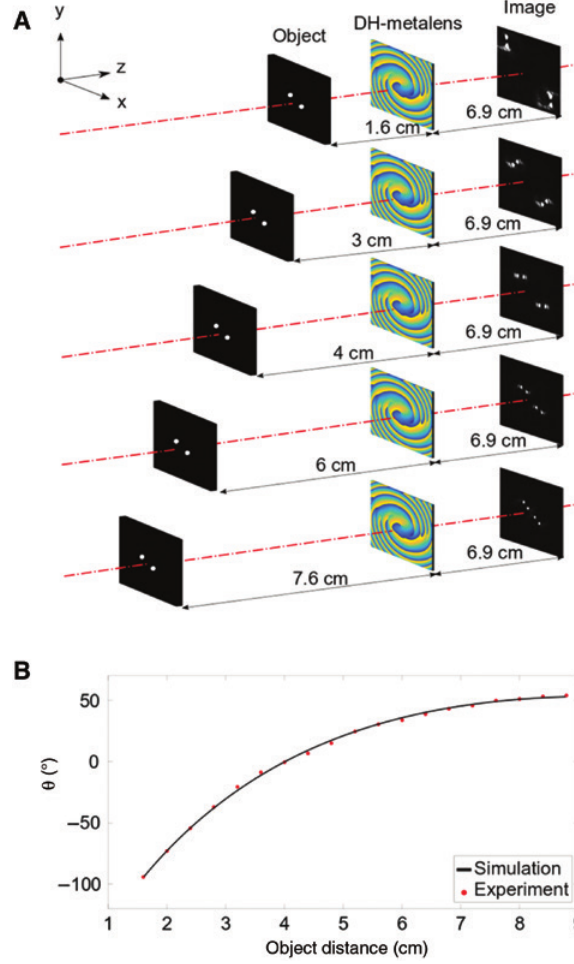
Figure 5: Experimental imaging of two moving microholes. (A) Images of two off-axis point sources (microholes) moving along the optical axis by fixing the imaging distance at 6.9 cm. Images for five object distances are shown. (B) Theoretically calculated and experimentally obtained rotation angle ( θ ) in the image as a function of the object